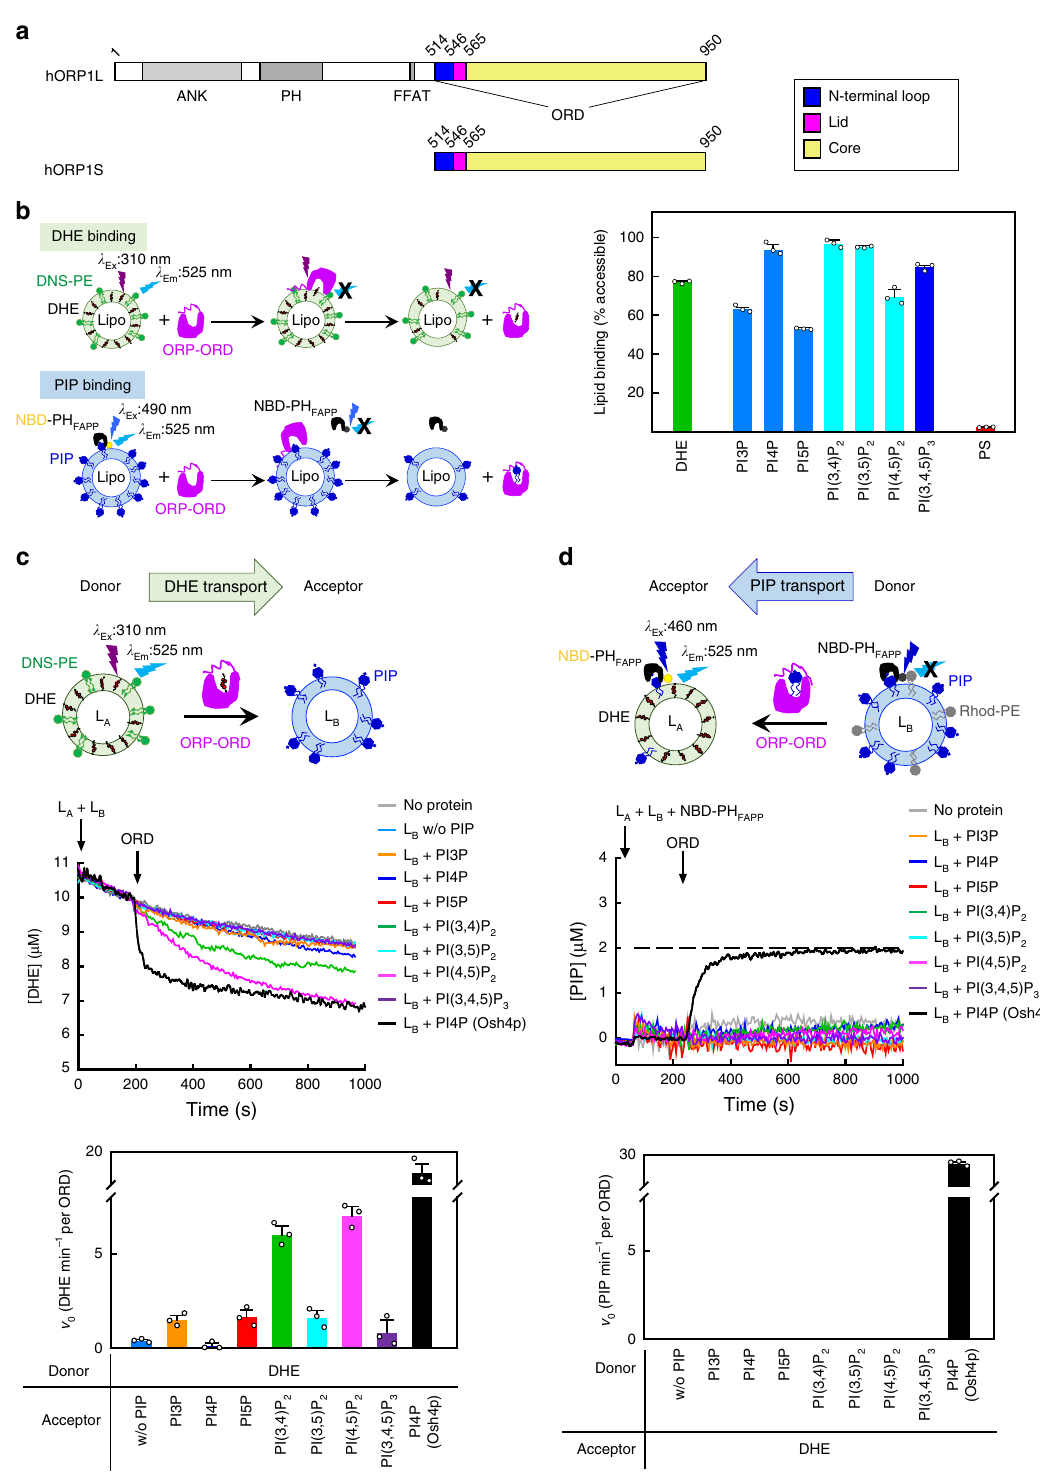
Fig. 1 ORP1-ORD transfers cholesterol but not PIPs. a Schematic diagram of human ORP1L and ORP1S. The structural elements in ORD are colored as follows: N-terminal loop (blue), lid (magenta), core (yellow). The color scheme of ORP1-ORD is consistent throughout the schematic representations unless indicated. b Lipid-binding analyses for ORP1-ORD. c DHE transport assays without or with PIP in the acceptor liposomes. Shown at the bottom are the initial velocities of DHE transport subtracted by that without ORP1. d PIP transport assays with DHE-containing acceptor liposomes. (For all bar graphs, data are shown as mean ± s.e.m. (error bar), n =